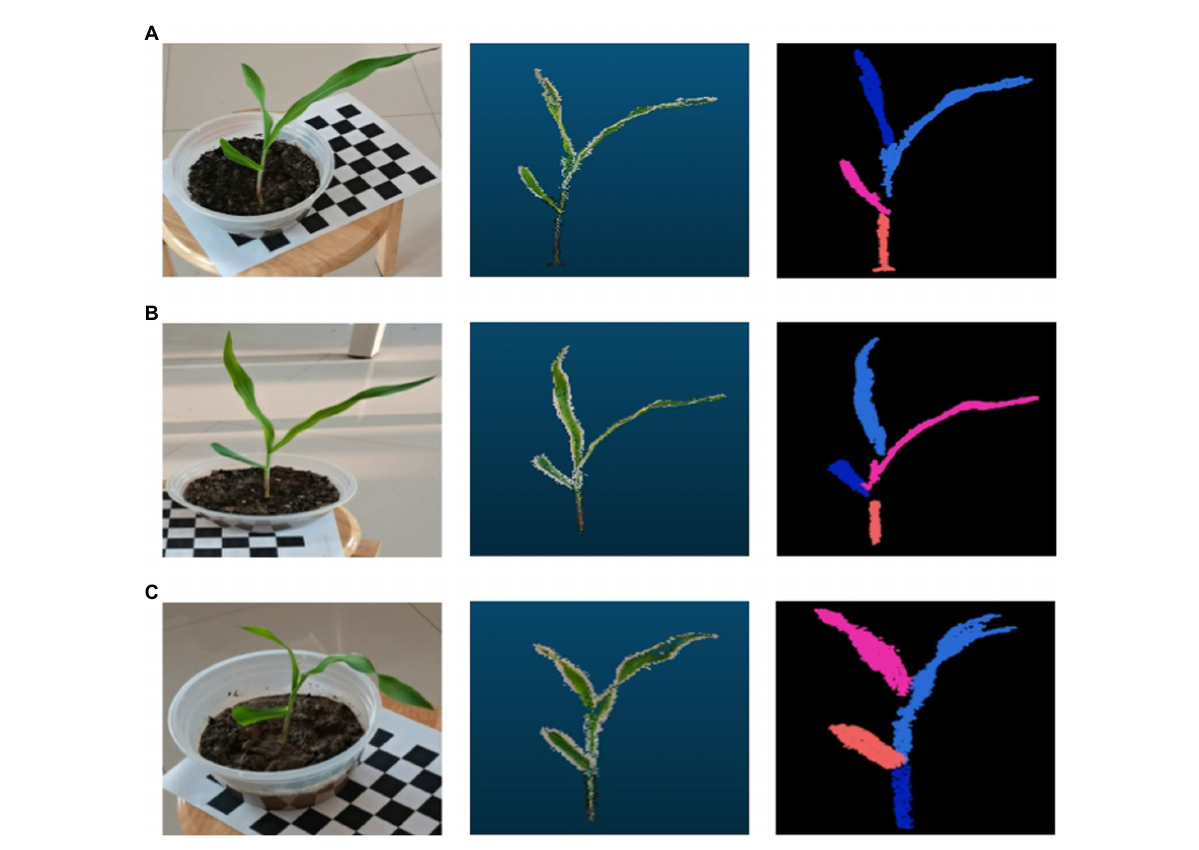
FIGURE 7 Maize point cloud segmentation based on region growth. In the three data sets (A-C) , the image on the left is when the data were collected, the middle one is the processed 3D point cloud image, and the image on the right is the corn point cloud after segmentation by the region growing